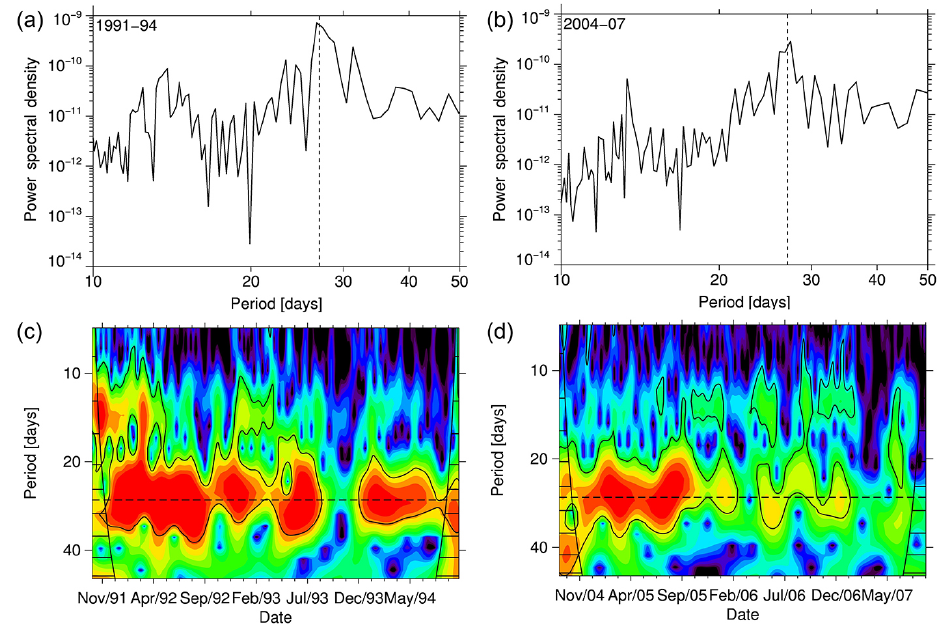
Figure 2. Top: F205 FFT power spectra (from NRLSSI model) for the (a) 1991–1994 and (b) 2004–2007 period. Bottom: time-resolved power spectra densities (or scalogram) estimated from continuous wavelet transform (CWT) for the (c) 1991–1994 and (d) 2004–2007 period. The vertical, horizontal, dashed lines in (a, b) and (c, d) indicate the 27-day period. The cone of influence, i.e., limit beyond which scalogram should not be interpreted, is marked by horizontal solid stripes. The solid contour lines represent the 95% confidence